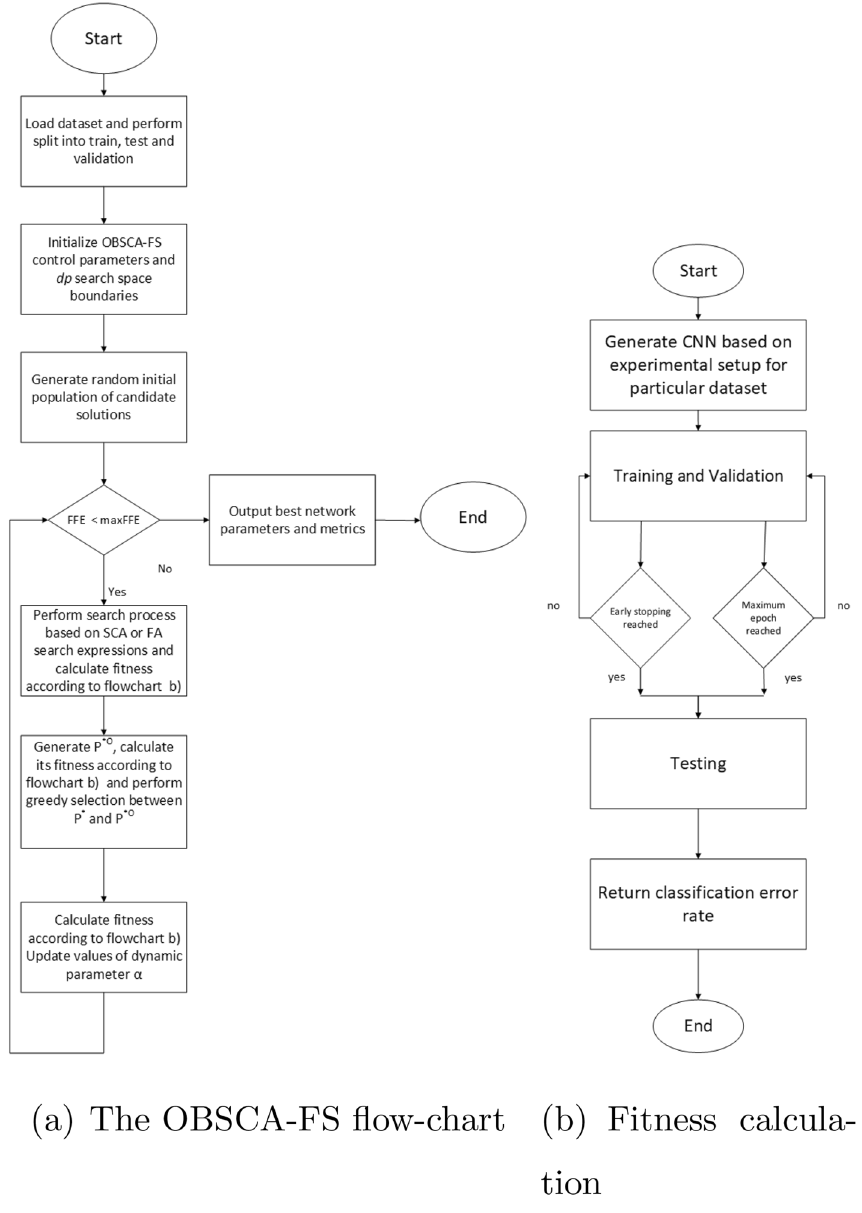
Figure 4. Proposed methodology for dp